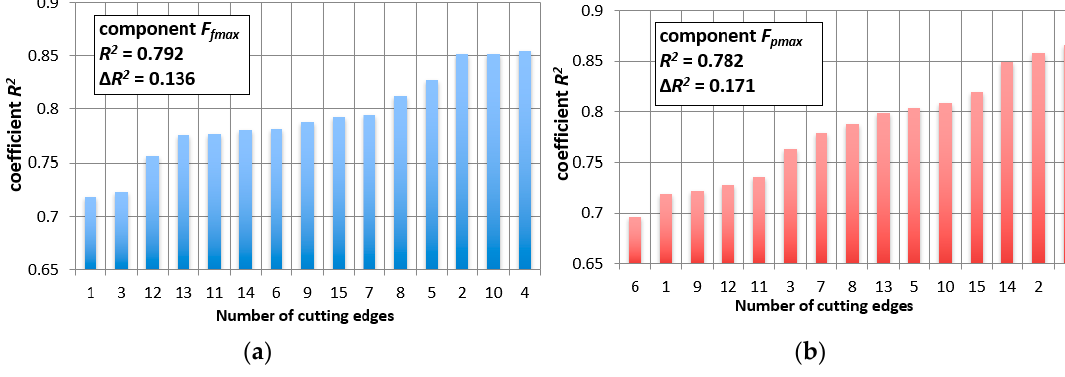
Figure 4. Matching coefficient, R 2 , for the: a) F f_max measure and b) F p_max. Materials 2019 , 12 , x FOR PEER REVIEW